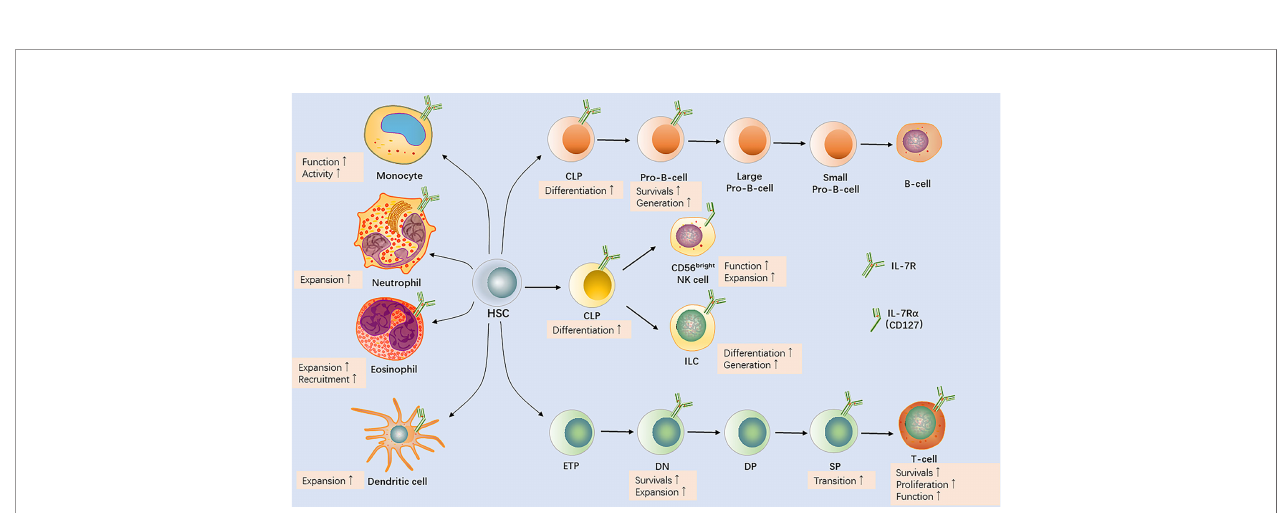
cell lineage progenitor; DN, double − negative; DP, double − positive; SP, single − positive.